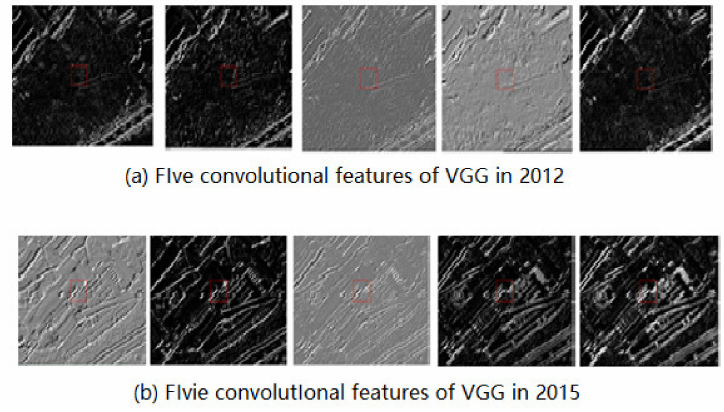
Figure 6. Convolution features of the Visual Geometry Group